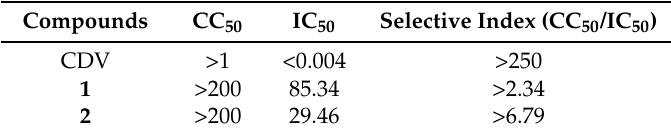
Table 2. Anti-Kaposi’s sarcoma associated herpesvirus (KSHV) activities of positive control cidofovir (CDV), 1 , and 2 ( μ M).